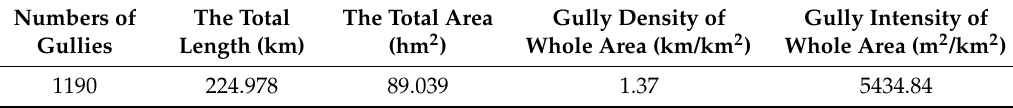
Table 2. Status of gully erosion in the Sancha River